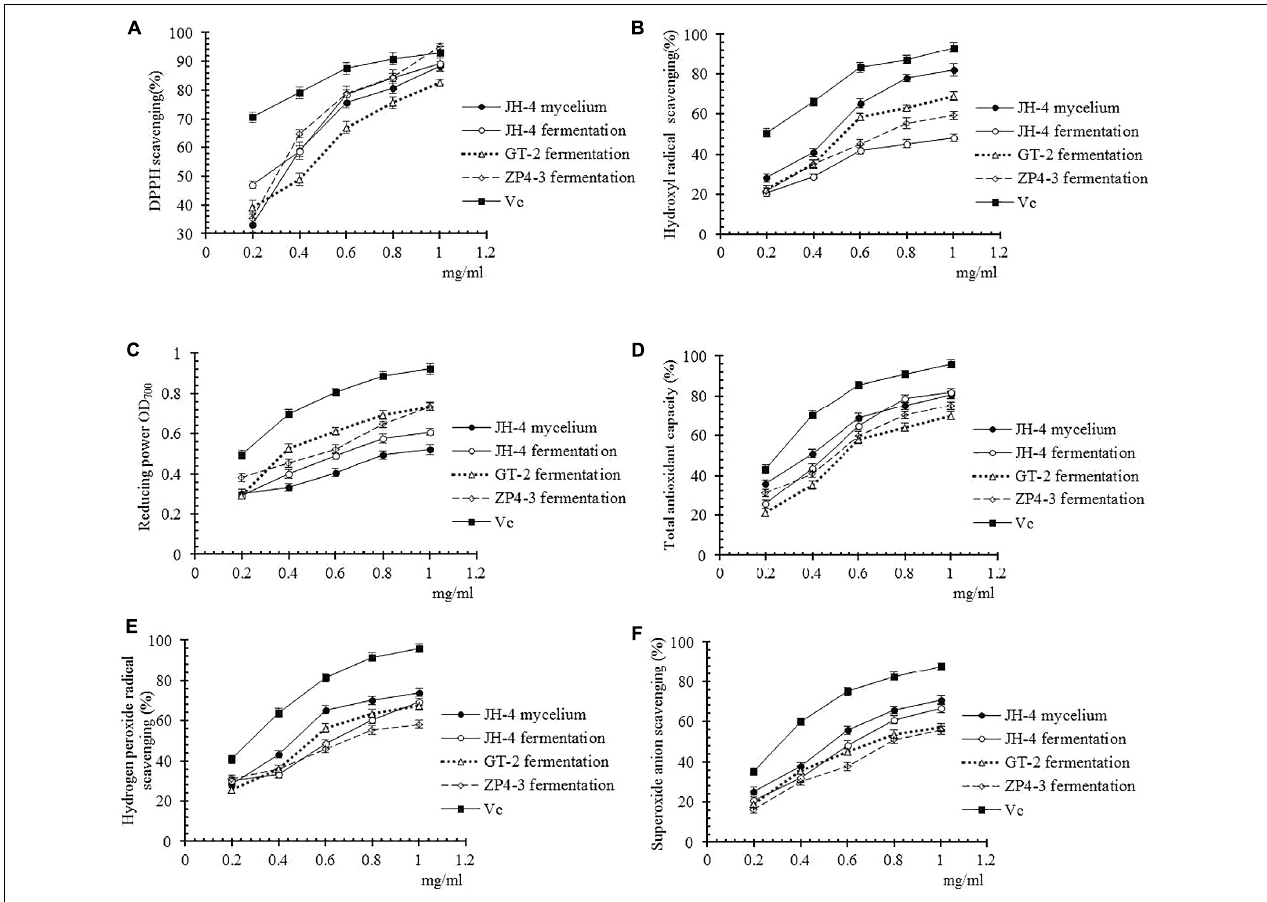
FIGURE 3 | Antioxidant activities of different samples. (A) DPPH radical scavenging activity. (B) Hydroxyl radical scavenging activity. (C) Reducing power. (D) Total antioxidant capacity. (E) Hydrogen peroxide radical activity. (F) Superoxide anion scavenging activity. TABLE 4 | IC 50 value from five antioxidant activity assays from four extracts of A . sinensis . IC 50 value (mg extract per